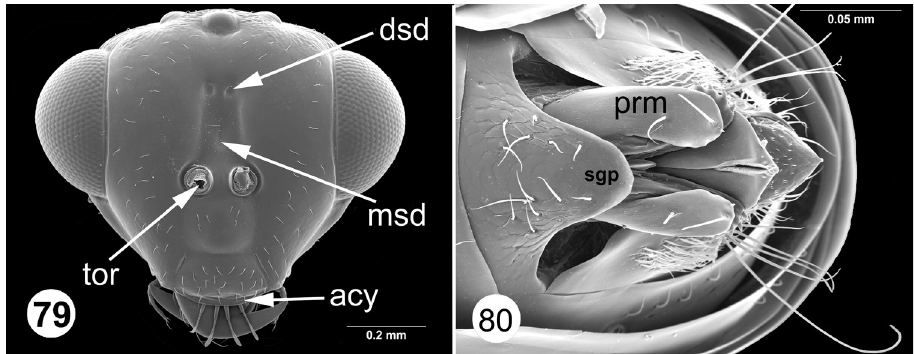
ventral. acy = anteclypeus; dsd = dorsal scrobal fovea; msd = median scrobal depression; prm = paramere; sgp = subgenital plate; tor =